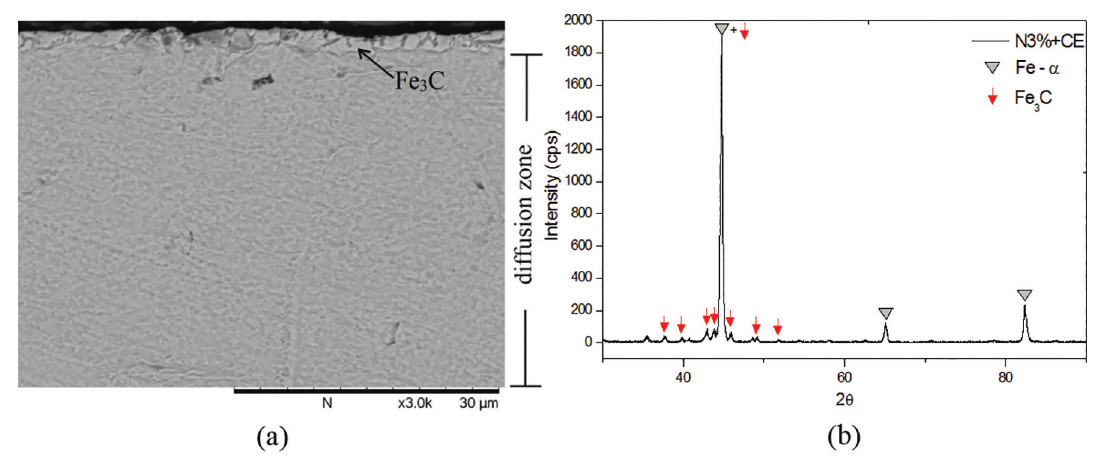
Figure 8: Sample N3%+CE: (a) scanning electron microscopy and (b) XRD. Table 3: Microhardnesses on the top and hardened depth of the studied samples. Treatment